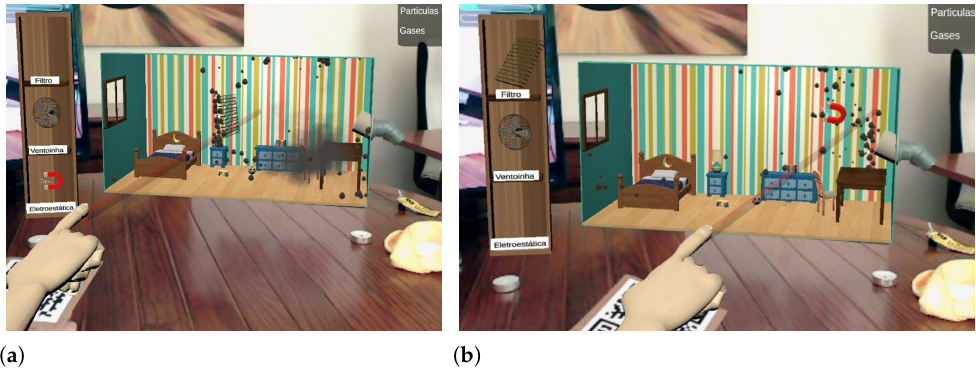
Figure 7. Interaction with the filter tool ( a ) and with the electrostatic tool ( b